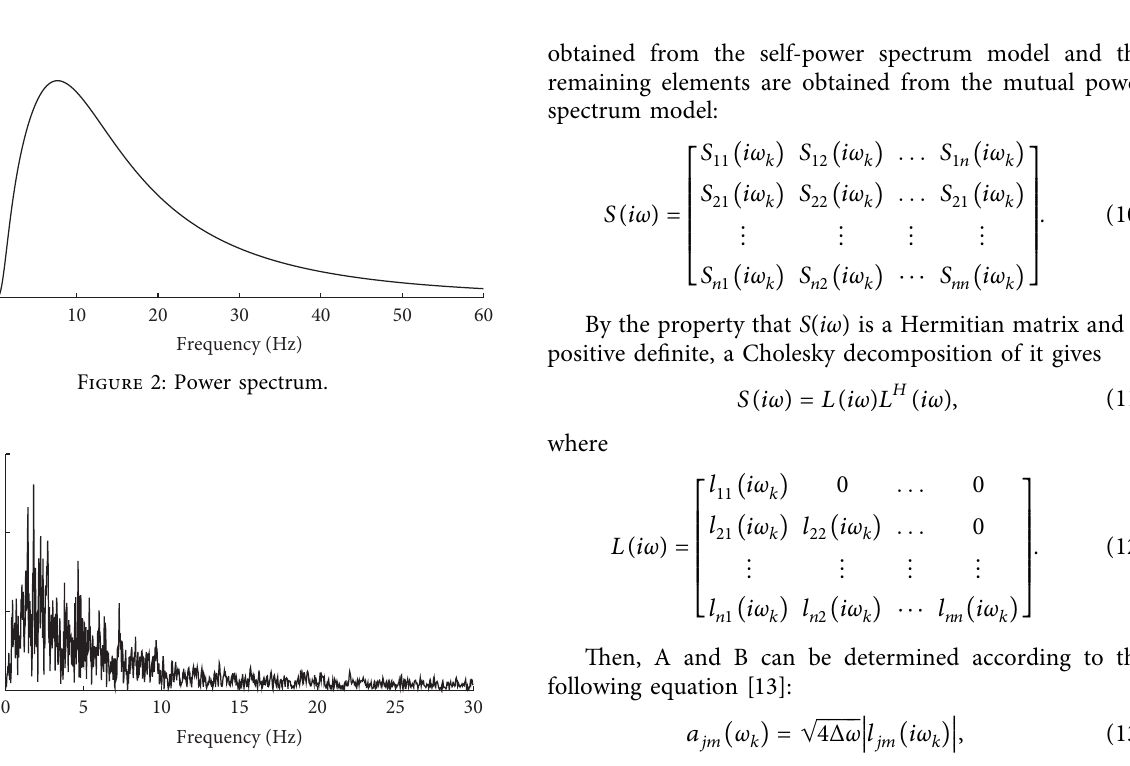
Figure 3: Power spectrum of EL-Centro wave.